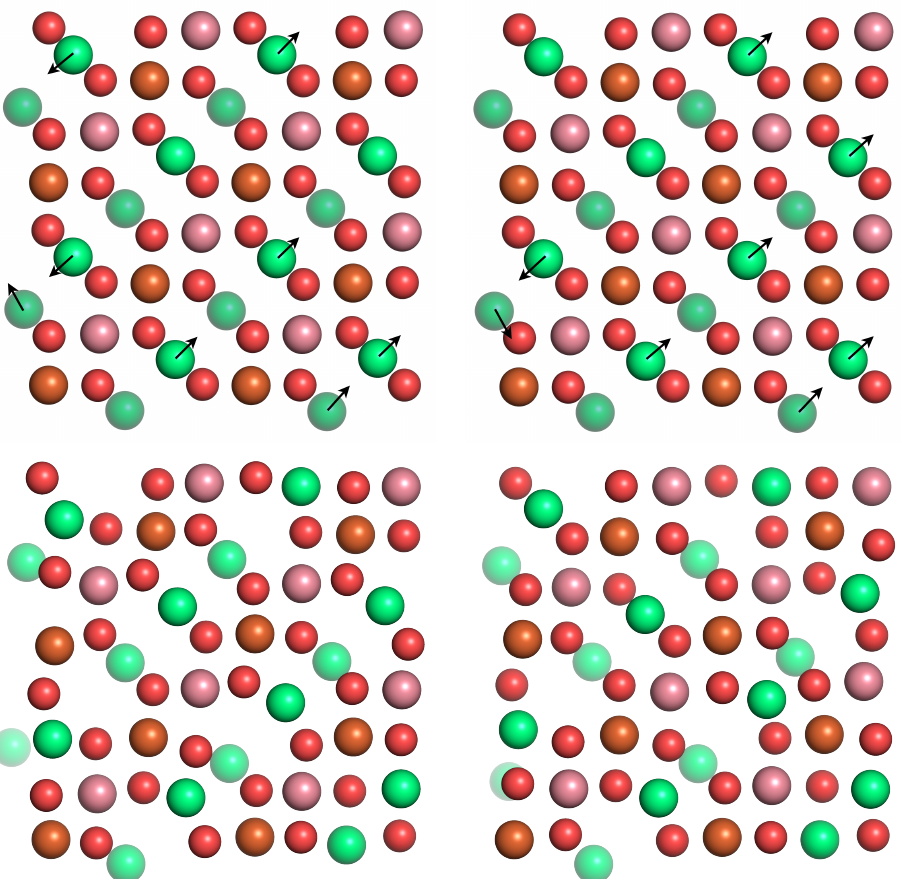
Figure 6. Top views of the initial (top row) and final (after 20 ps; bottom row) surface structures for A-terminated water-free ( left ) and water covered ( right ) CoFe 2 O 4 (001) surfaces, with atom coloring Fe 3+ (oct): brown, Fe 3+ (tet): green, Co 2+ : purple, O: red as in Figure 2. Fe 3+ (tet) ions below the top surface layers are partially greyed out. The arrows indicate the reconstruction of the Fe 3+